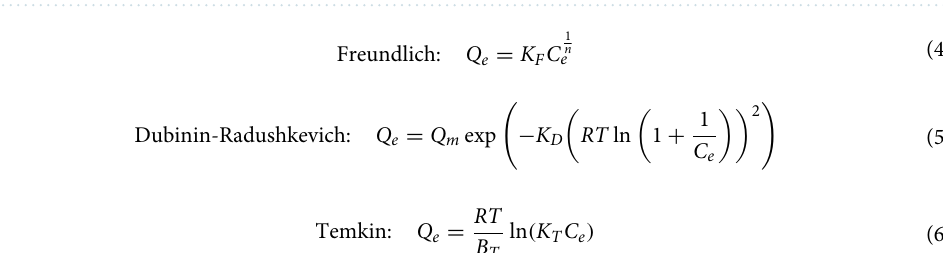
Figure 5. Isotherm curves under different temperatures for ( a ) MO adsorption at pH of 5 and ( b ) CV adsorption at pH of 7; solid lines: Langmuir, dashed lines: Freundlich, dotted lines: Dubinin-Radushkevich, dash-dotted lines: